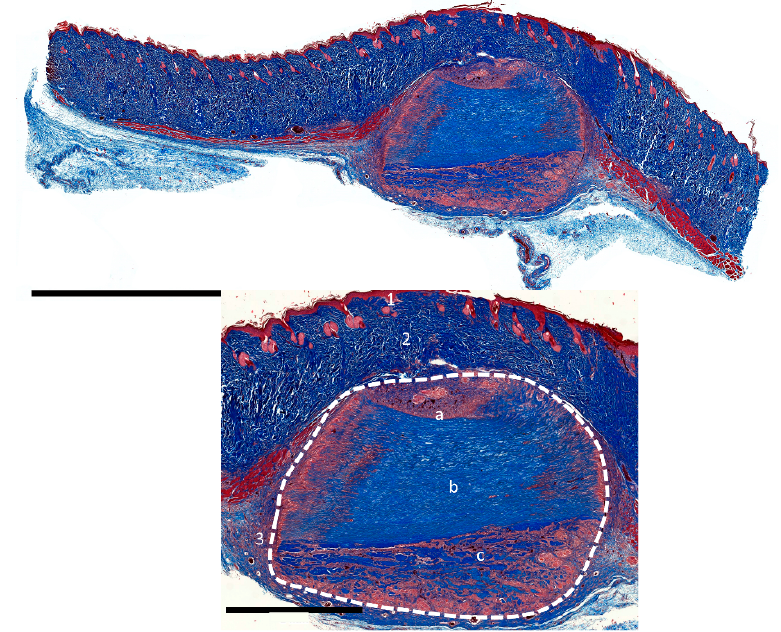
Figure 9. Cross-sectional overview and closeups of the subcutaneous implantation model of the porcine aortal patch (PAP). Dashed line: implant, 1: epidermis, 2: dermis, 3: subcutaneous layer, a: tunica intima, b: tunica media, and c: tunica adventitia. (Images were stained with Azan, magnification: 20 × and scale bars = 5 mm (overview) and 2 mm (magnified)).